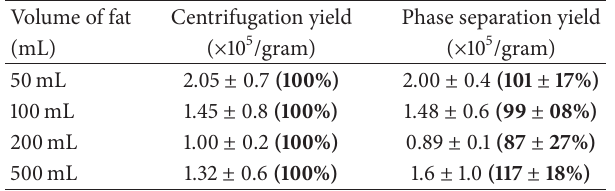
Table 2: SVF yield from lipoaspirates processed by whole digest centrifugation and aqueous phase separation.